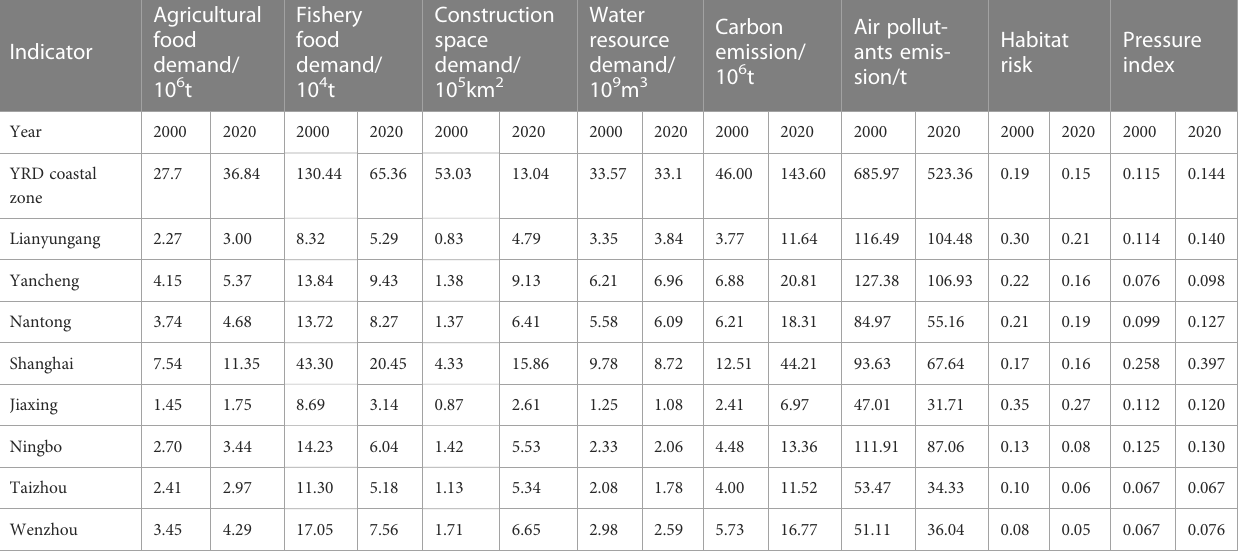
TABLE 2 Pressure index value in